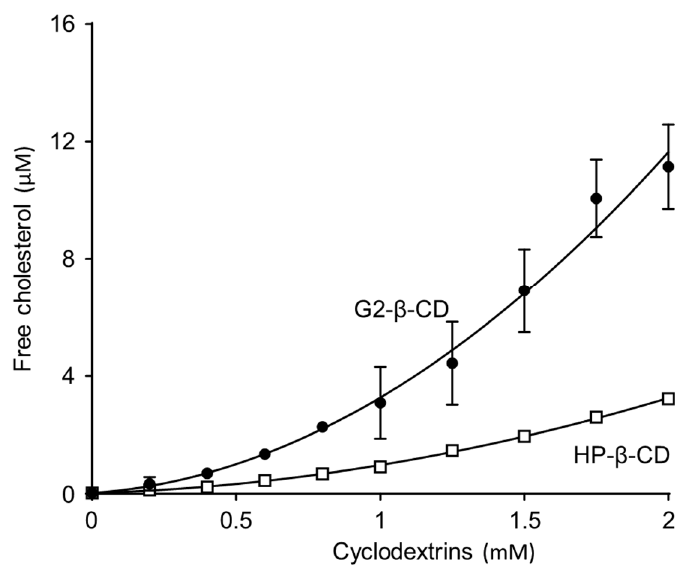
Figure 3. Solubility-curve analysis to evaluate the solubilizing ability of G2- β -CD (closed circle) and HP- β -CD (open square) with free cholesterol (FC) in culture media. The solubility of FC was measured in DMEM/F12 medium (1:1) at 37 °C. Each point represents the mean ± S.D. ( n = 3–5).